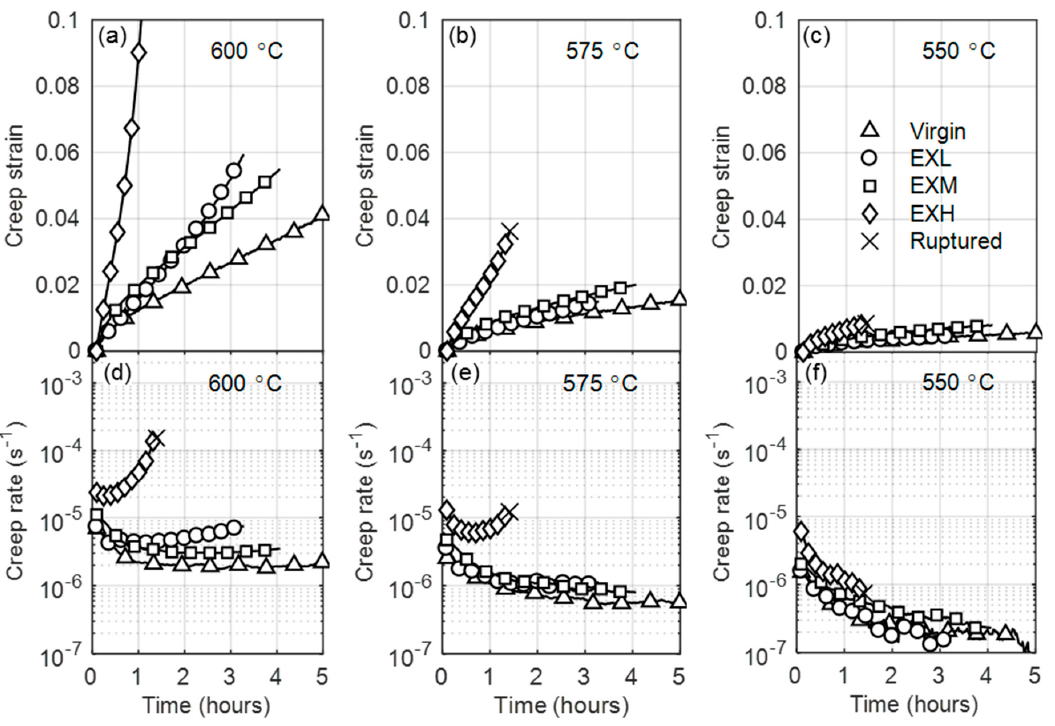
Figure 4. Comparison between the creep strains ( a – c )) and creep rates ( d – f )) of virgin and service-exposed material at 600 °C, 575 °C, and 550 °C for column 1, 2, and 3, respectively, for an applied stress of 250 MPa. Legend is given in ( c ).